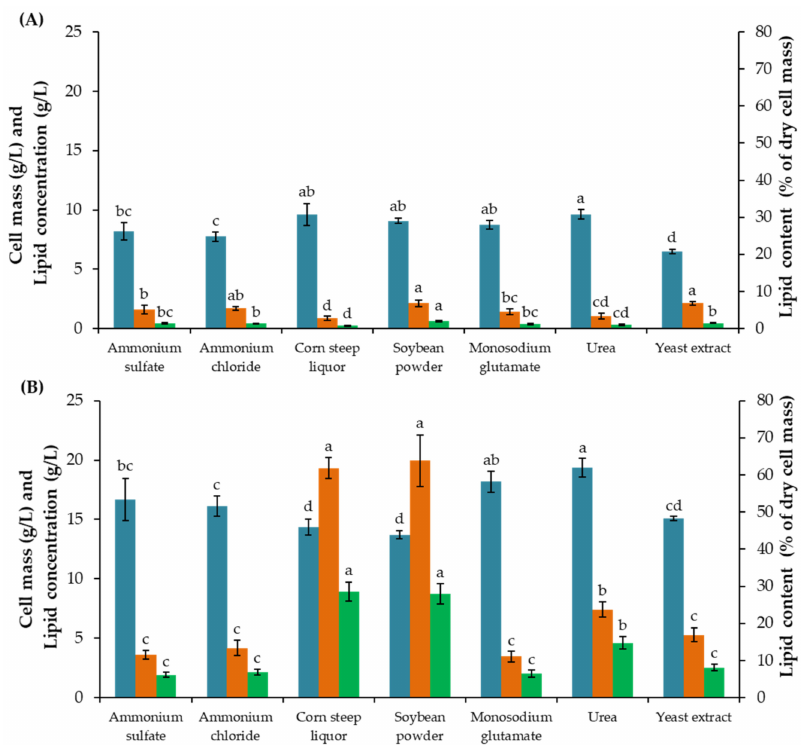
Figure 1. Cell mass ( (cid:4) ), lipid content ( (cid:4) ) and lipid concentration ( (cid:4) ) by R. fluvialis DMKU-SP314 cultivated in a STH medium in various additional nitrogen compounds ( A ) at the end of the first stage (120 h) and ( B ) at the end of the second stage (240 h) in 70 g / L of CG solution with a pH of 5.5 while incubated at 150 rpm and 28 ◦ C throughout the cultivation. Data are presented as mean value ± standard deviation. The di ff erent, same and overlapping lower-case letters mean significantly di ff erent, no-significantly di ff erent, and on-significantly di ff erent of their overlapping according to Duncan’s multiple range test at p ≤